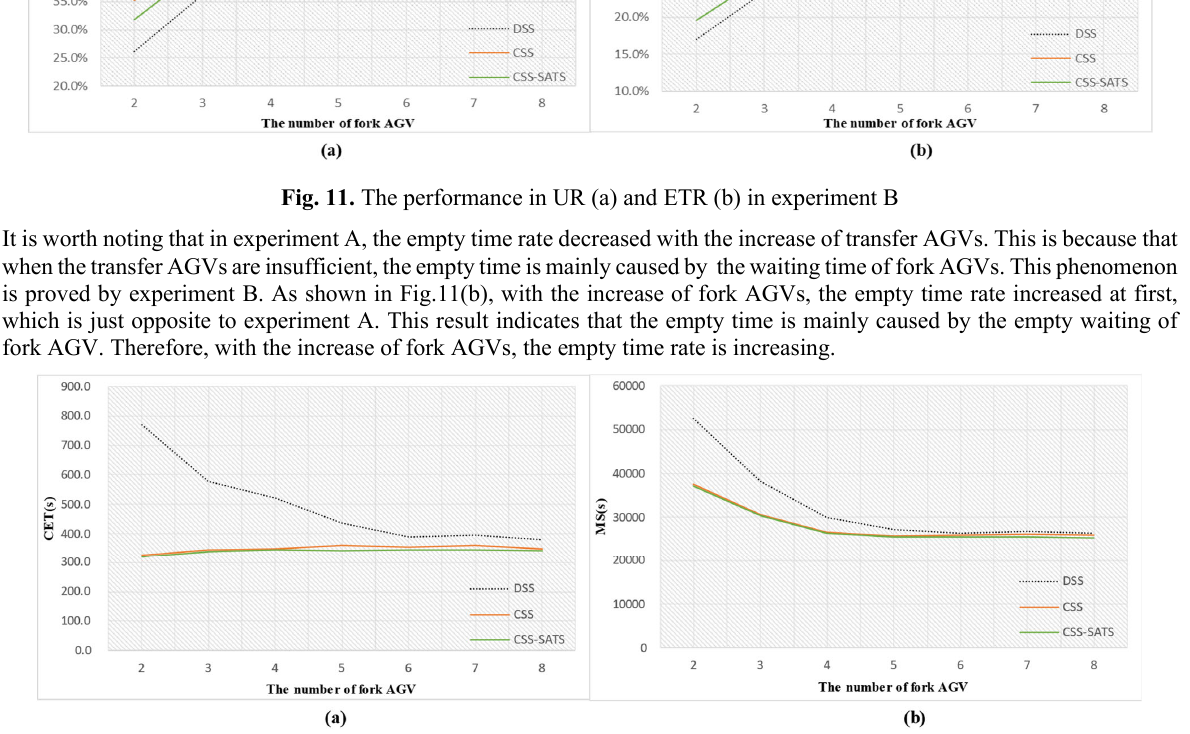
Fig. 12. The performance in CET (a) and MS (b) in experiment